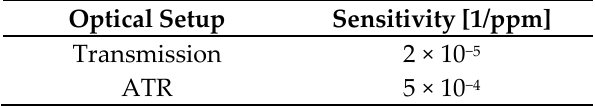
Figure 2. ( a ) Spectral response of a binuclear rhodium complex to CO concentrations from 20 ppm to 100 ppm in ATR mode; ( b ) Transient response of a colorimetric sample to CO concentrations in the range from 20 ppm to 200 ppm in ATR mode at 470 nm. Table 1. Comparison of the sensitivity to CO in transmission and ATR mode.